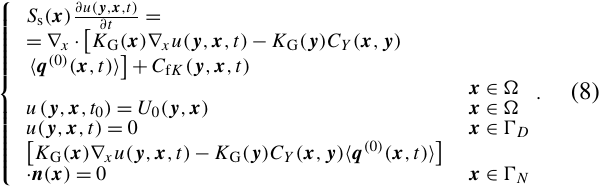
Figure 1. Type of monitoring wells: pointwise (Type A), partially (Type B) and fully penetrating (Type C) observation